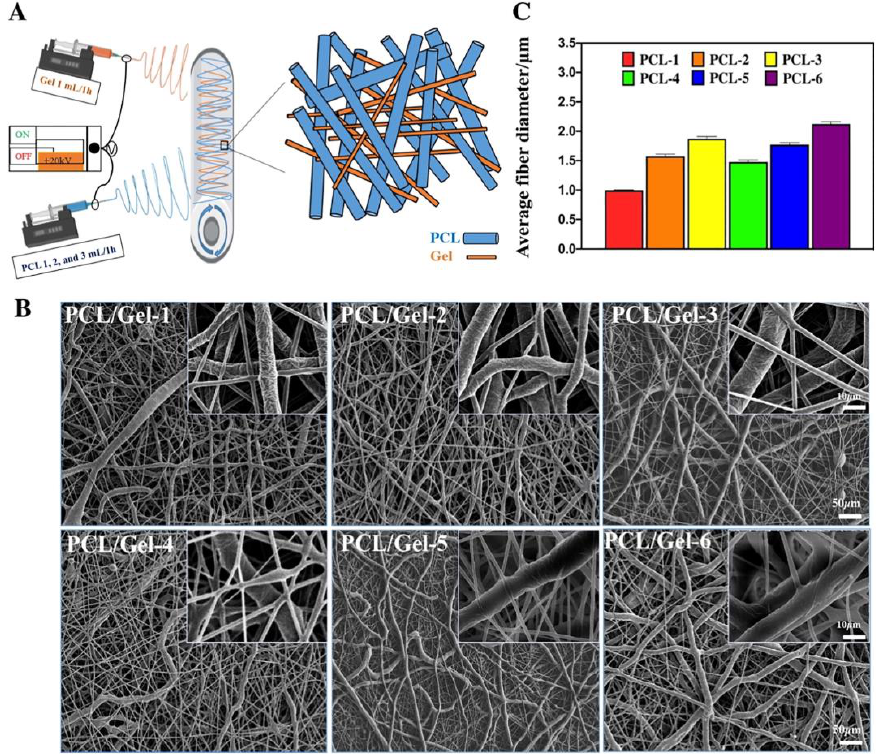
Figure 3. ( A ) Schematic illustration of the PCL/Gel membrane prepared by co-electrospinning tech- nique; ( B ) SEM images of different PCL/Gel co-electrospinning membranes at various magnifications; and ( C ) the statistics of fiber size in different co-electrospinning membranes [123] . The phase separation technique is one of the simplest methods for obtaining mem- branes. Phase separation can occur when the thermodynamic quality of a polymer solu- tion usually decreases when the temperature is decreased, and by immersion precipitation [124]. Zeinali et al. [125] reported Poly(butylene succinate) (PBS) membrane via thermally- induced phase separation (TIPS) for Curcumin (CUR) and piperine (PIP) release. Addi- tionally, it was reported that the variation of solvent system, thermal gradient and cooling direction changed the pores ’ architecture, which could affect the release profile. The inter- facial polymerization method is used for membrane formation, which is one of the most important processes in commercial fabrication [126]. In this method, the polymer solution and the solvent are poured onto a flat surface to form a film. After that, the controlled process of exchanging solvent for a nonsolvent takes place, leading to a membrane for- mation [127]. Ding et al. [128] described an antibacterial and anti-inflammatory membrane based on porphyrin-covalent organic frameworks (COF) with encapsulated ibuprofen (IBU) via an in situ interfacial polymerization and impregnation approach. The reported membrane displayed high O 2 generation and controllable ibuprofen release at body tem- perature for wound healing. Generally, the surface modification of membranes is carried out for better biocom- patibility and biodegradability [108]. The biocompatibility of the membrane is repre- sented by it is represented by the response to the interaction with biological fluids, with- out triggering any kind of immune response or infection. The most used techniques for membrane surface modification are blending [129], grafting[130] and plasma initiation [131]. The blending surface modification method is one of the most convenient methods due to reduced cost. Liang et al. [132] proposed the improvement of the blending strategy